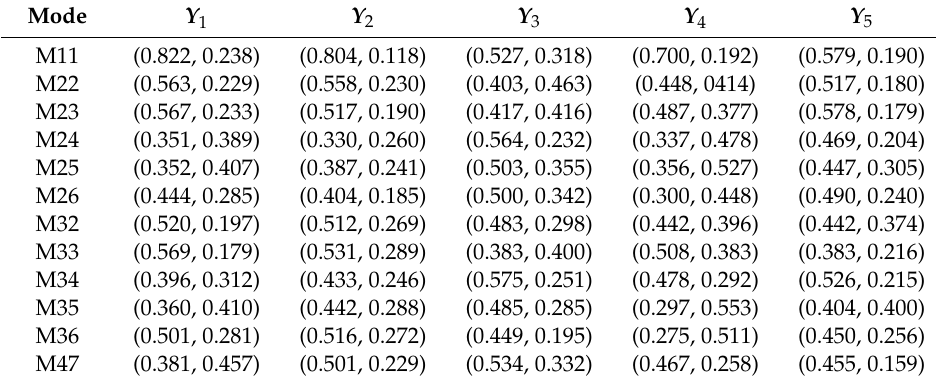
Table 9. Expert judgment information aggregation based on the intuitionistic fuzzy hybrid average (IFHA) operator.